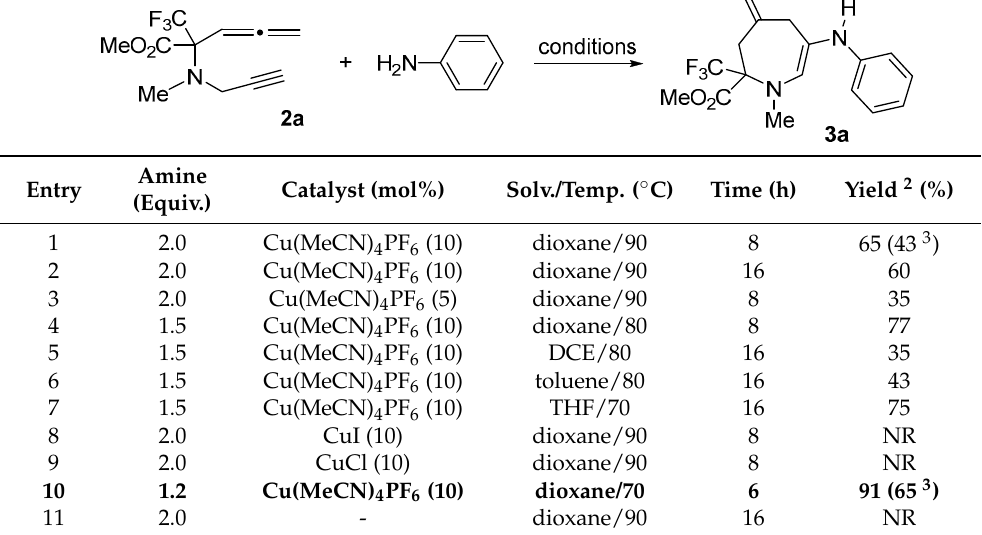
Table 1. Optimization of amination/cyclization of allenyne 2a with aniline 1 .